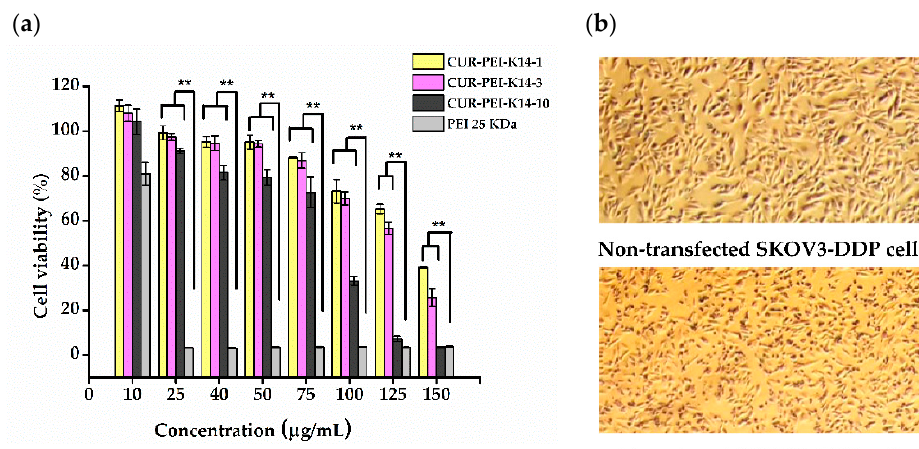
Figure 7. ( a ) Cytotoxicity of CUR-PEI-K14 and PEI 25 kDa at various concentrations in SKOV3-DDP cell lines using the 3-(4,5-dimethyl-2-thiazolyl)-2,5-diphenyl-2- H -tetrazolium bromide (MTT) assay. ( b ) Representative microscopic images of nontransfected SKOV3-DDP and transfected SKOV3-DDP cells. Each data point represents the mean ± standard deviation ( n = 6, ** P <